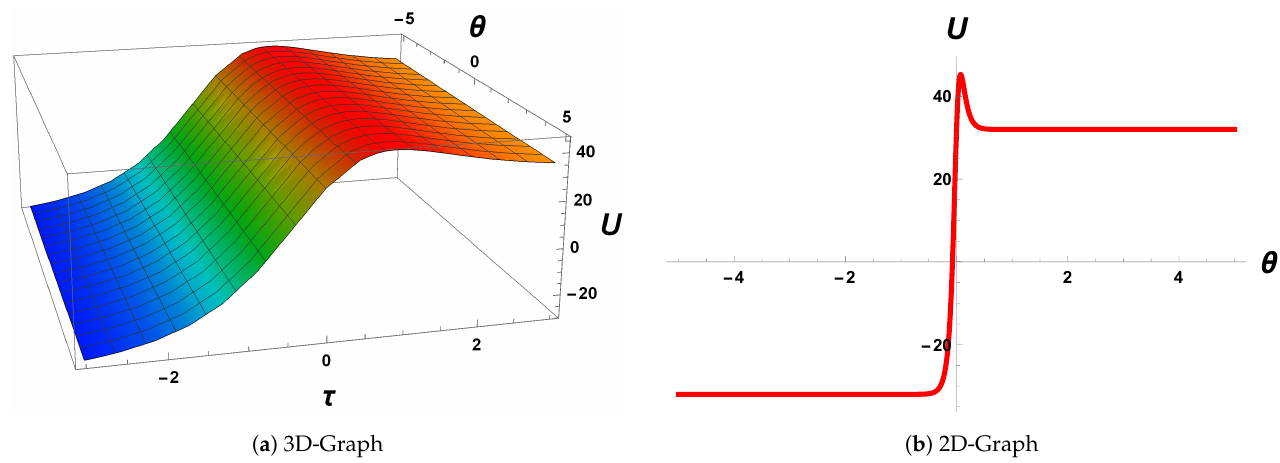
Figure 6. Diagrams a − 3 D and b − 2 D representation of U 7 ( θ , τ ) for l 1 = 1.5, l 2 = 0.75, δ = 2, γ 1 = 2, γ 2 = 0.5, and γ 3 = 1.7.